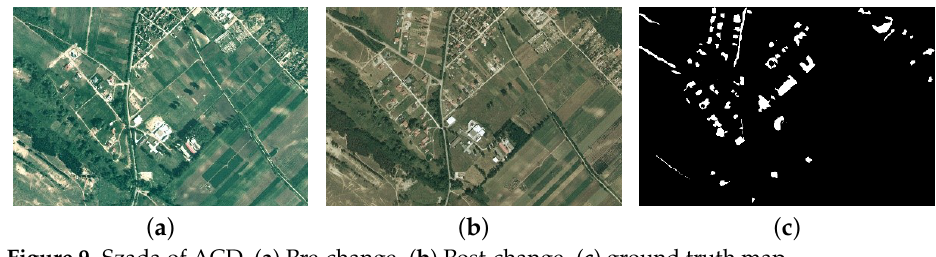
Figure 9. Szada of ACD. ( a ) Pre-change. ( b ) Post-change. ( c ) ground truth map.